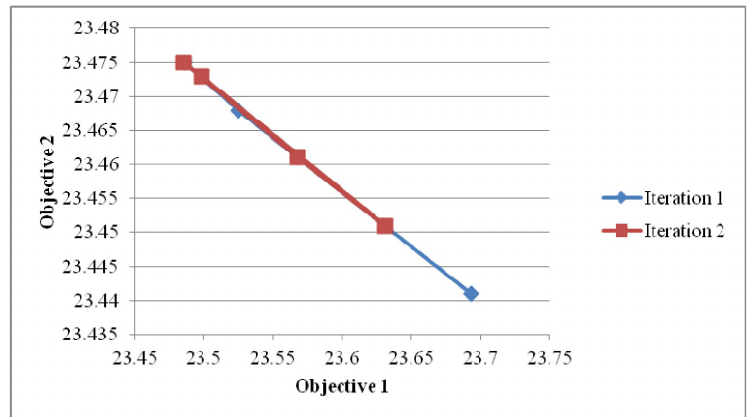
Figure 3. Pareto front which was made through two iterations of